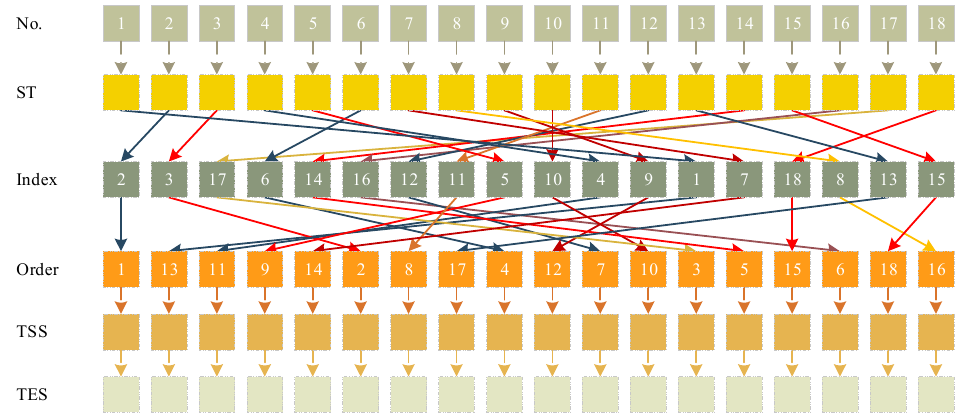
Figure 12. Parallel coordinate graph of experimental result.